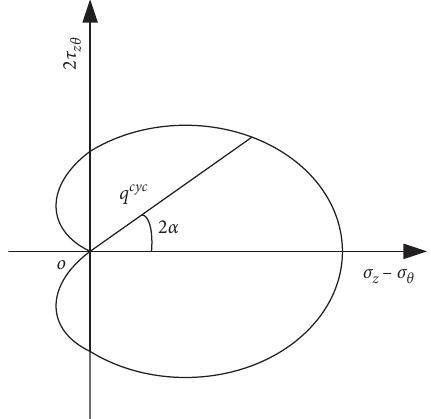
Figure 1: Schematic diagram of stress